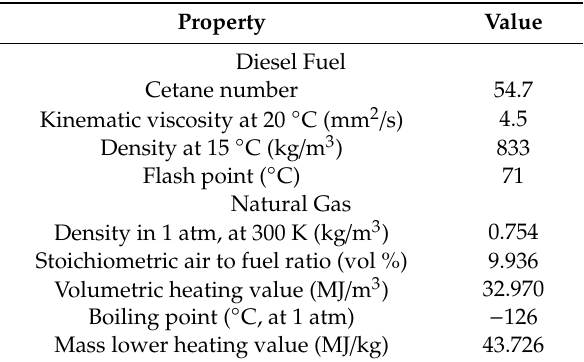
Table 2. Properties of the used fuels.